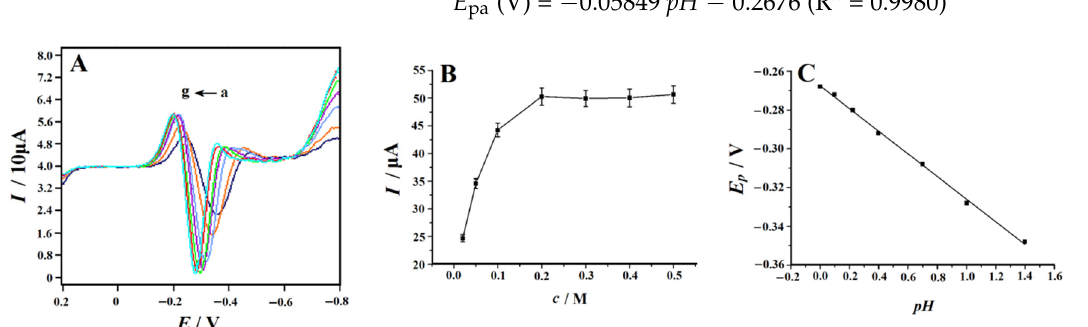
Figure 5. ( A ) Second-derivative linear sweep voltammograms of 0.1 mM 4-NP recorded on the NC–PEI/GCE at a scan rate of 0.1 V s − 1 in H 2 SO 4 solution with different concentrations (from a to g are 0.02, 0.05, 0.1, 0.2, 0.3, 0.4 and 0.5 M) after accumulating at 0.2 V for 150 s; ( B ) plot of the peak current versus H 2 SO 4 concentration, error bars represent SD, n = 3; ( C ) the linear relationship between the peak potential and pH.